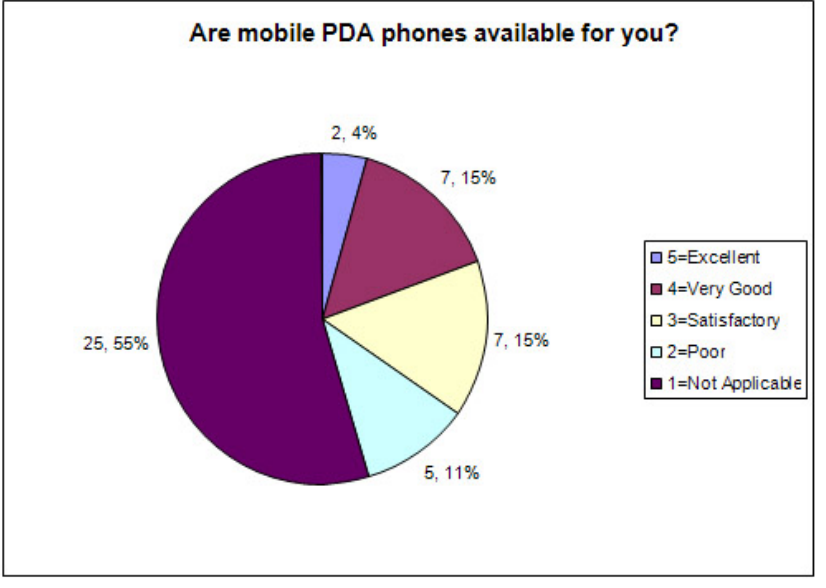
Figure 3. Mobile PDA Phone availability survey